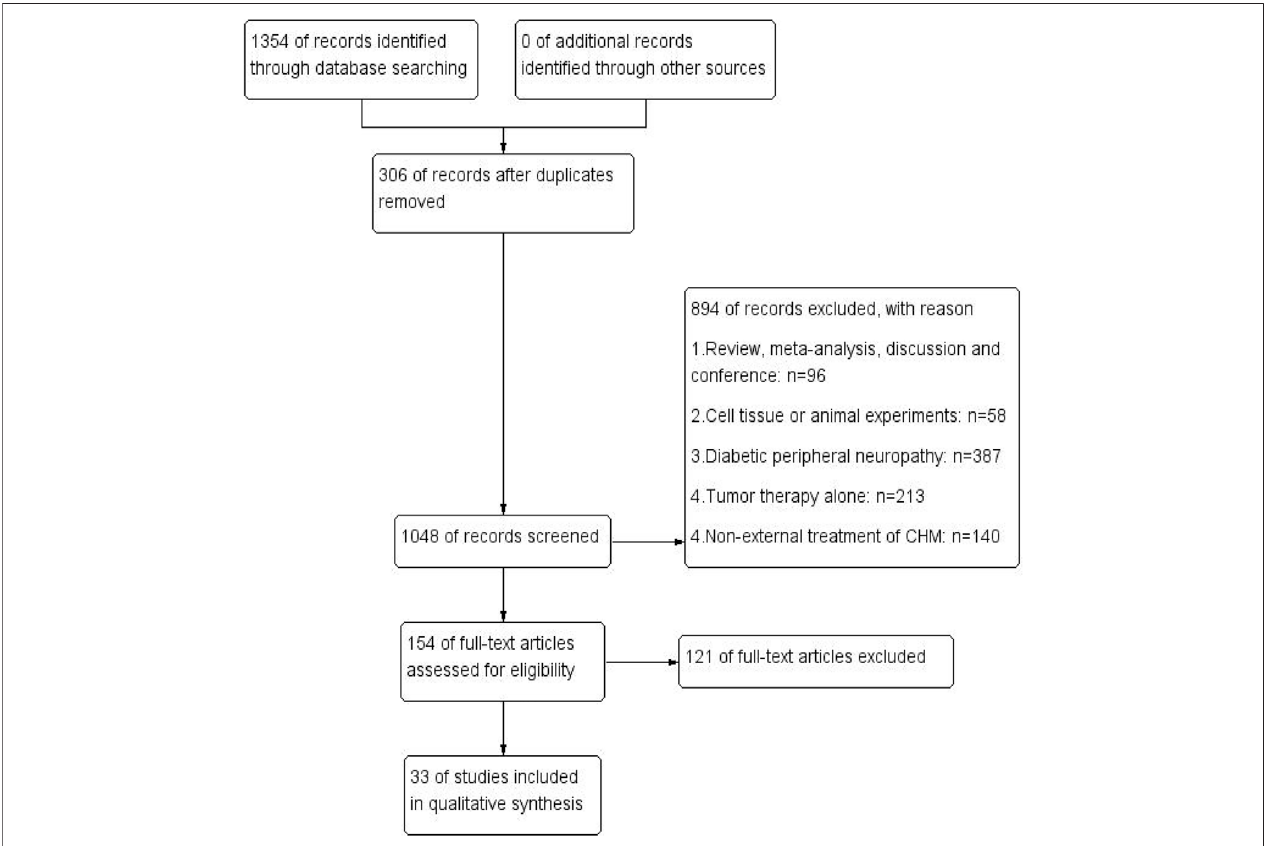
FIGURE1| Flowchartofliterature identi fi cation andscreening.PubMed( n =49),Cochrane library( n =44), WebofScience( n =79), MEDLINE( n =3),OVID( n =8), CNKI ( n = 234), CBM ( n = 528), VIP ( n = 40), and WANFANG ( n = 369).